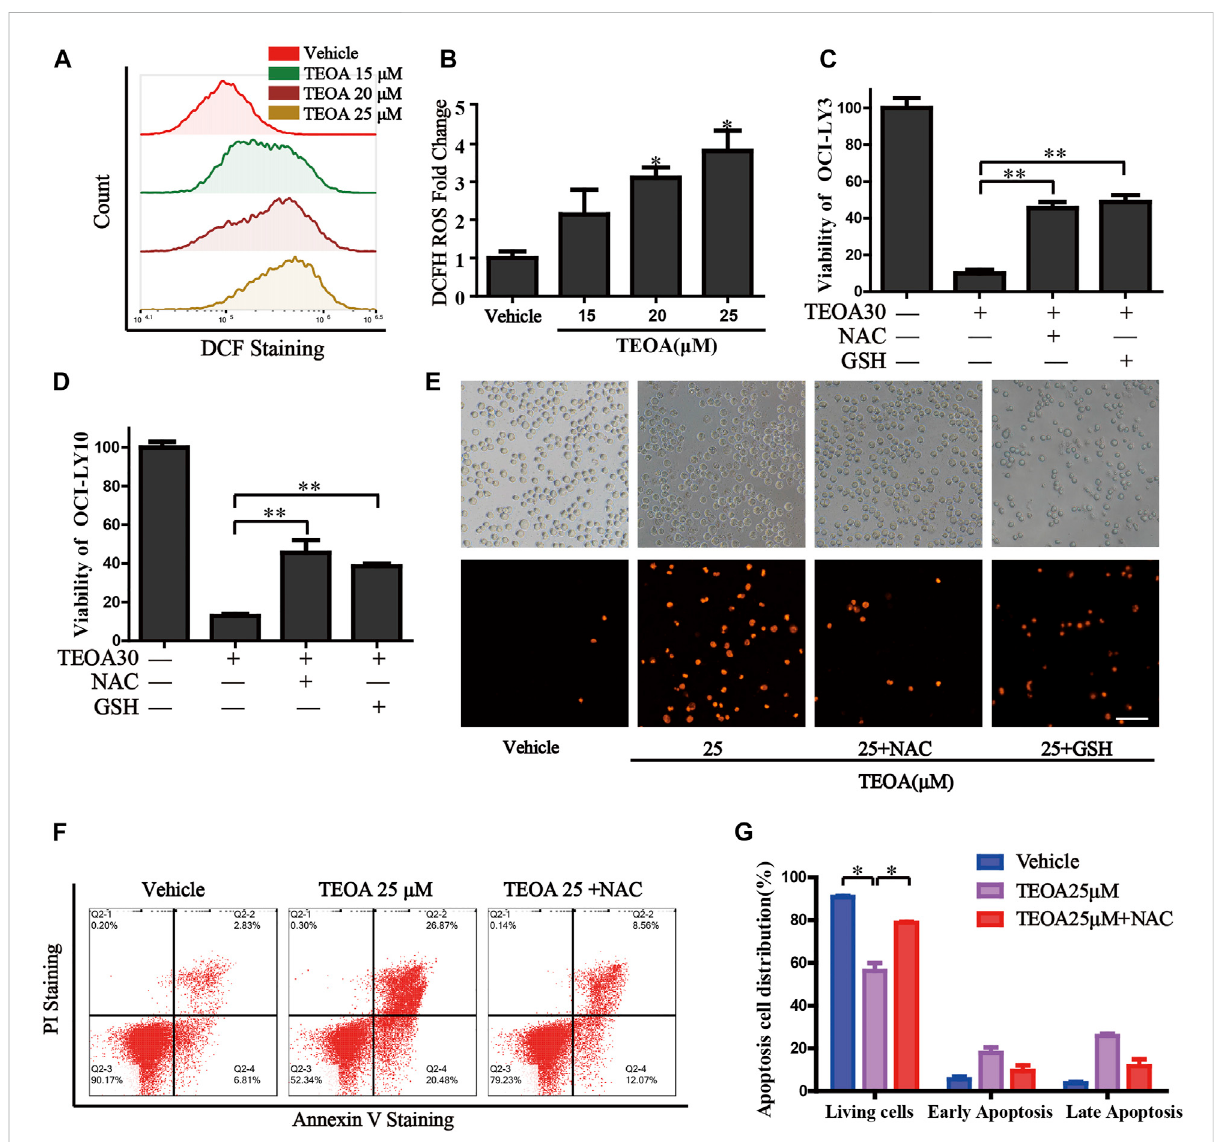
FIGURE 4 |TEOAincreasedtheproductionofcellularROSandpromotedapoptosis. (A) OCI-LY10cellswereexposedtodifferentconcentrationsofTEOA for 12 h, then treated cells were stained with DCF-DA for 30 min,cellular ROS levels were determined by fl ow cytometry. (B) Quantitativeanalysis of thecellularROS, p p < 0.05.OCI-LY10andOCI-LY3cellsweretreatedwithTEOAfor12 hinthepresenceorabsenceofNACandGSH,celldeathwas determined by CCK8 assay (C,D) and PI staining (E) . (F) Flow cytometry was used to detect apoptosis in DLBCL cells exposed to TEOA with or without NAC treatment. (G) The proportion of apoptotic cells was shown on the right, p p <